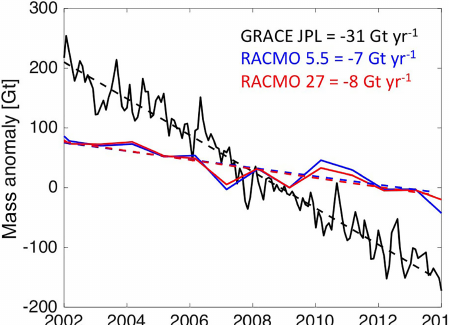
Figure B1. Rates of 2002–2014 mass change as derived from lin- ear fits to cumulative anomalies of RACMO surface mass balance determined at 5.5km (blue line) and 27km (red line), and JPL V2.0 mascon anomalies (black line: http://grace.jpl.nasa.gov/data/ get-data/jpl_global_mascons/) for the northern Antarctic Peninsula. Surface mass balance and JPL mascon anomalies were integrated for the seven mascons overlapping the northern Antarctic Peninsula (4324, 4325, 4372, 4373, 4374, 4415, 4416). For plotting purposes the surface mass balance anomalies were determined relative to the 1979–2003 mean. JPL mascons are corrected for changes in solid earth using the glacial isostatic adjustment (GIA) correction mod- eled by Geruo A and John Wahr. This figure is provided to support the argument for a relatively steady rate of northern Antarctic Penin- sula mass change between the 2003 and 2015 and not to support the magnitude of that change, which is sensitive to the choice of the model used for the GIA